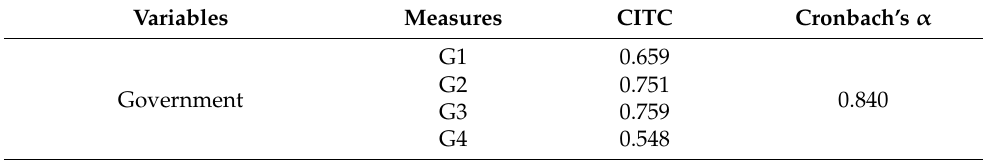
Table 6. Results of measuring model